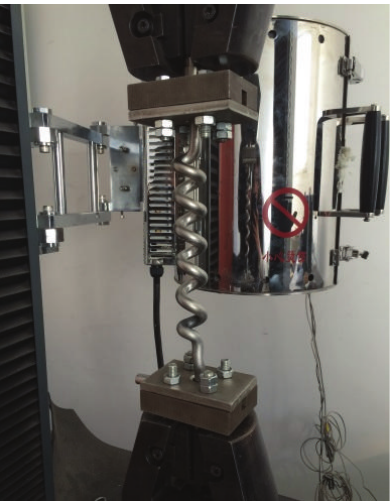
Figure 3: Large-scale SMA helical spring.